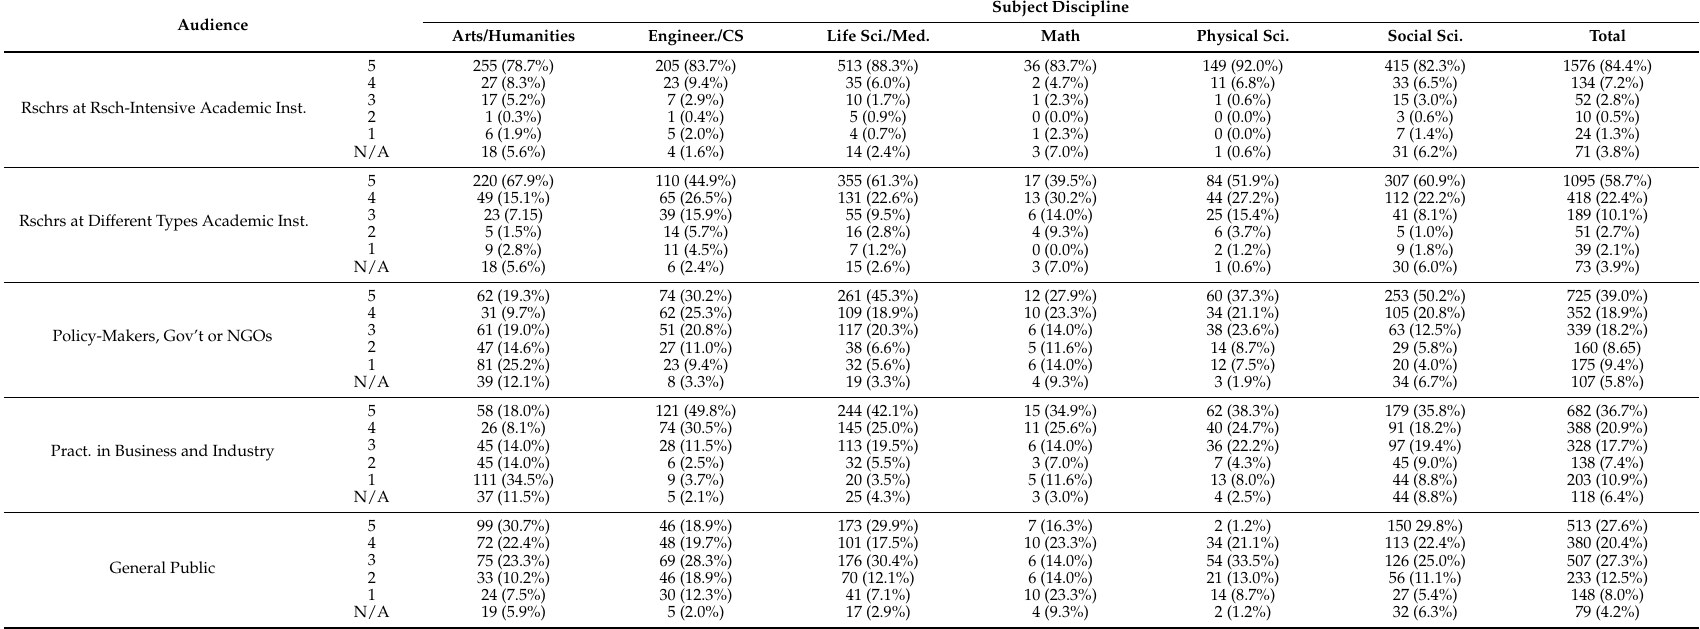
Table 16. Importance of accessibility: percentage by subject